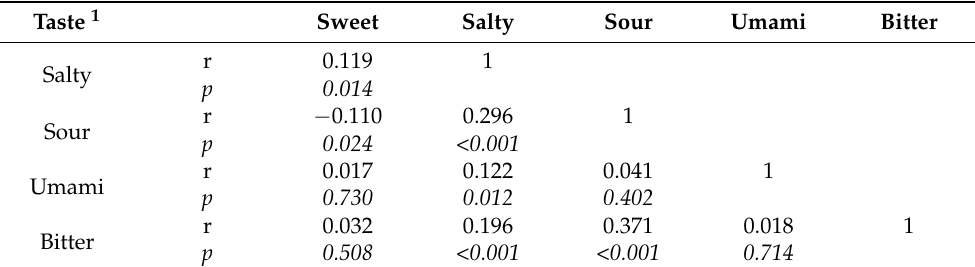
Table 4. Association between the preference for different